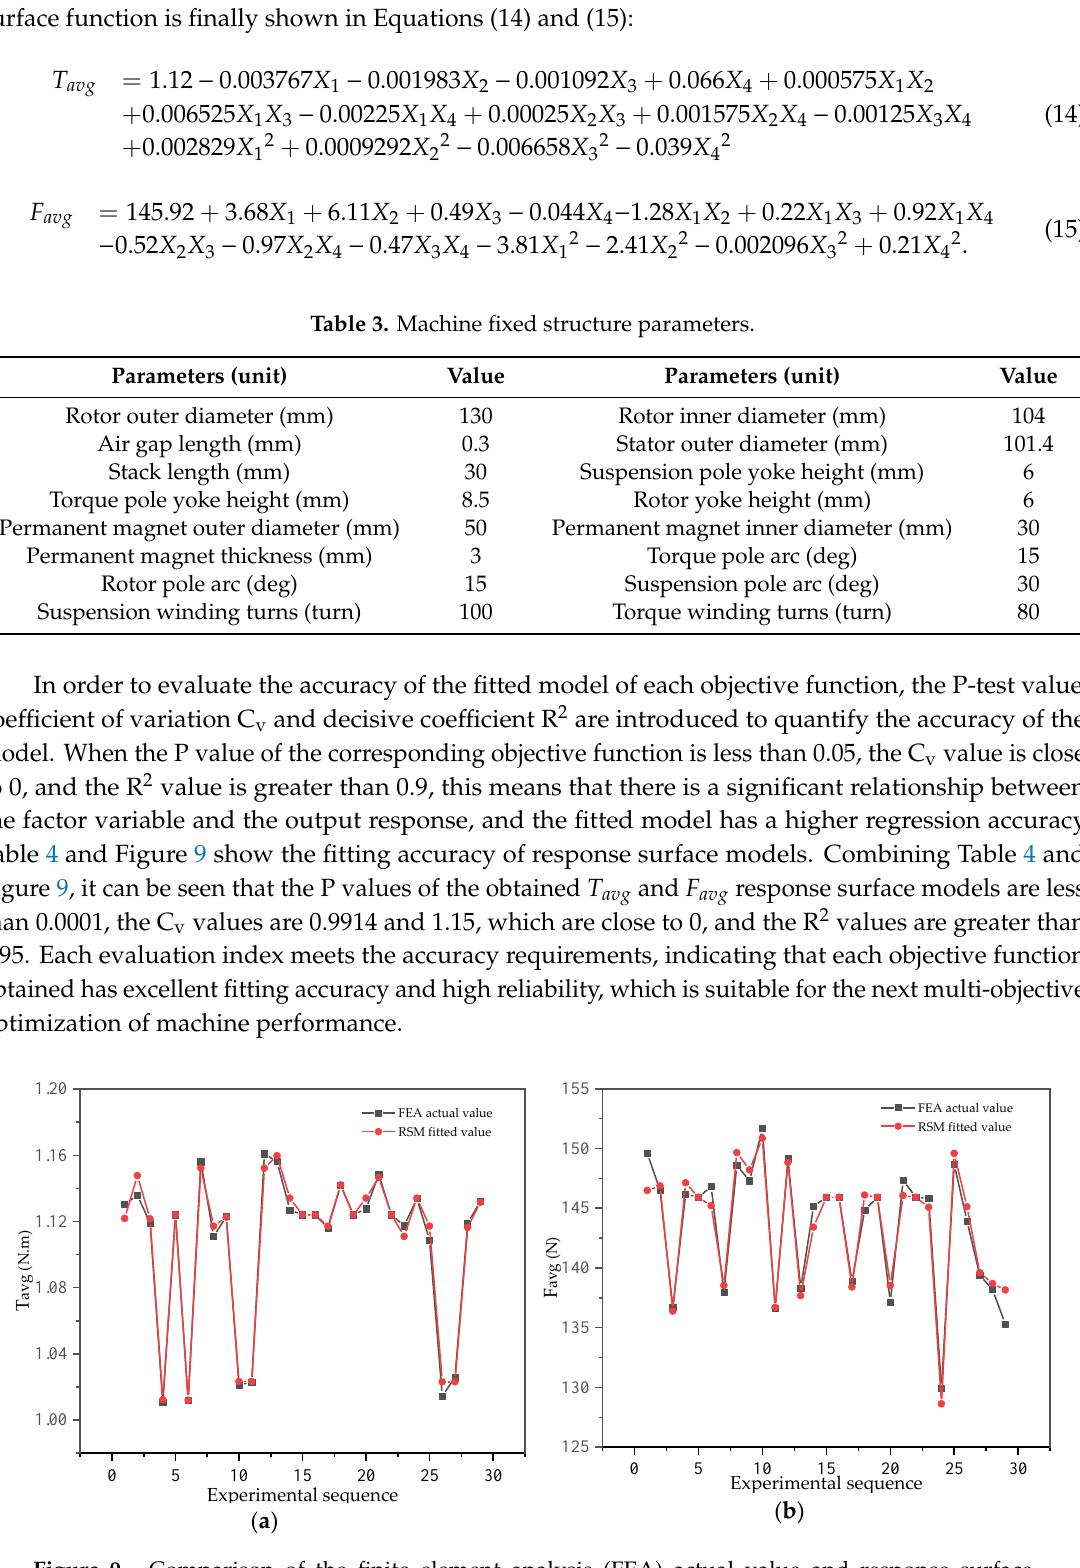
Figure 9. Comparison of the finite element analysis (FEA) actual value and response surface methodology (RSM) fit value: ( a ) average torque T avg ; ( b ) average suspension force F avg .